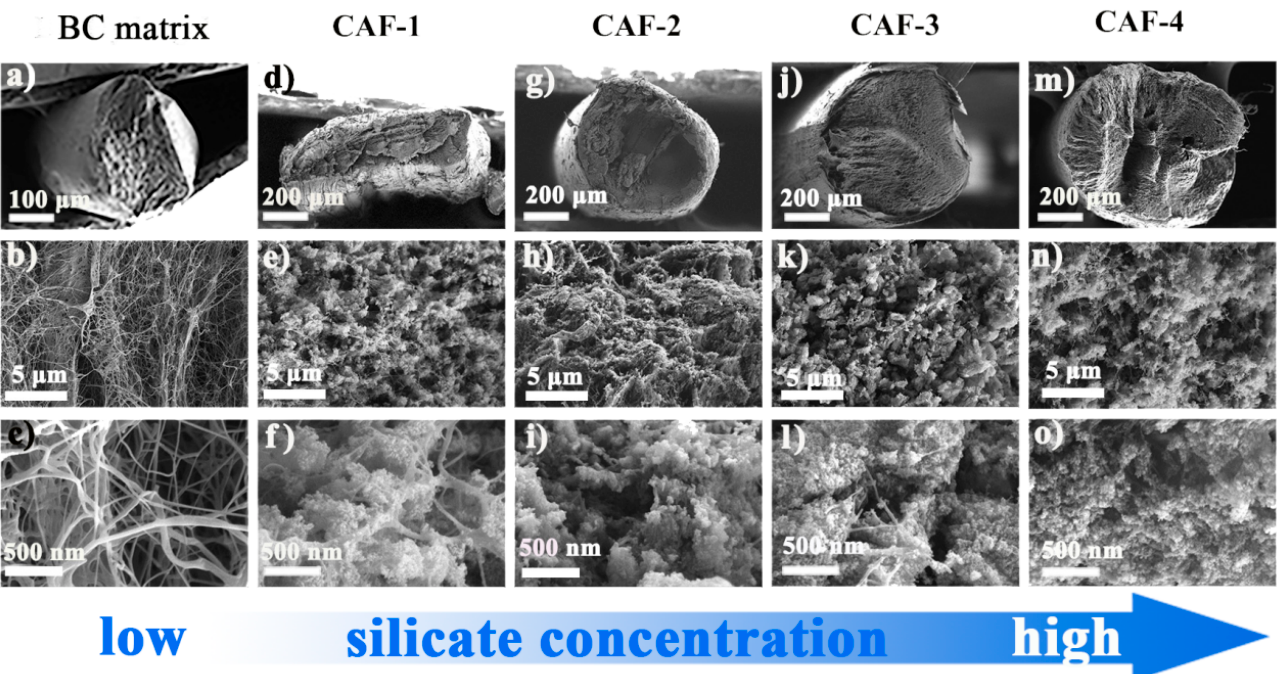
Figure 4. SEM images of BC matrix and CAFs with different magnifications (( a – c ) were SEM images of BC matrix enlarged by 50 × , 5000 × and 20,000 × . ( d – f ), ( g – i ), ( j – l ) and ( m – o ) were SEM images of CAF-1, CAF-2, CAF-3 and CAF-4 enlarged by 100 × , 5000 × and 20,000 × , respectively).